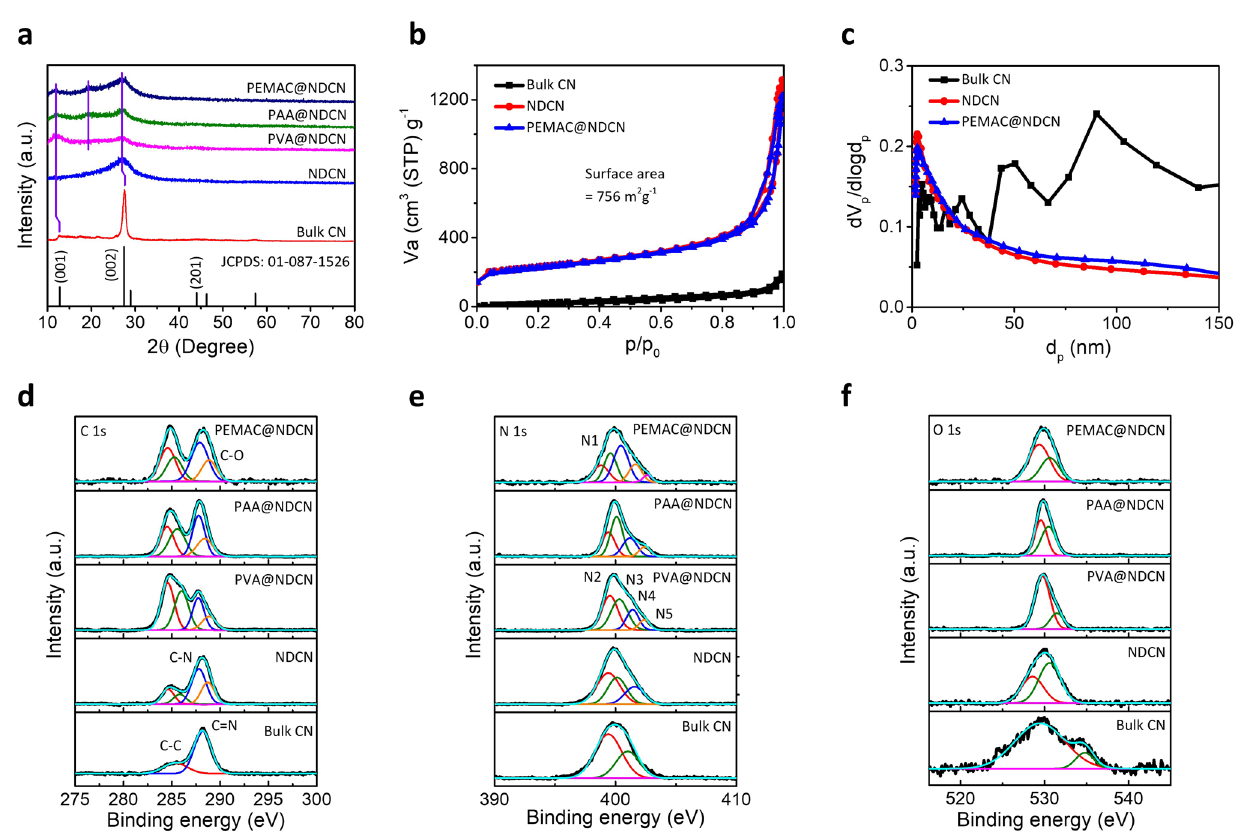
Fig. 3 Spectroscopic characterizations of free‑standing metal‑free catalysts. a X‑ray diffraction patterns for bulk CN, NDCN, PVA@NDCN, PAA@NDCN, and PEMAC@NDCN catalysts. b N 2 sorption isotherms of PEMAC@NDCN compared to bulk CN and NDCN. c Pore distri‑ bution statistics of PEMAC@NDCN compared to bulk CN and NDCN. XPS spectra of d C 1 s , e N 1 s , and f O 1 s for the designed PEMAC@ NDCN compared to those of other polymers PVA@NDCN, PAA@NDCN, and NDCN, bulk